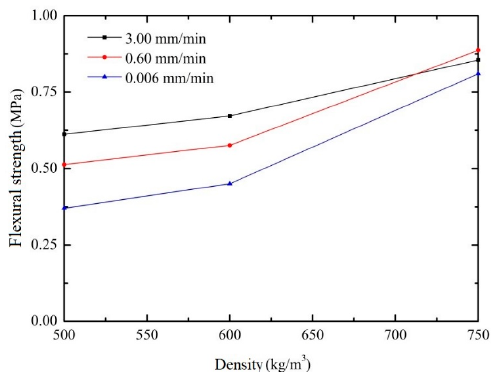
Figure 13. Relationship between flexural strength and density of foam concrete under different loading rates.